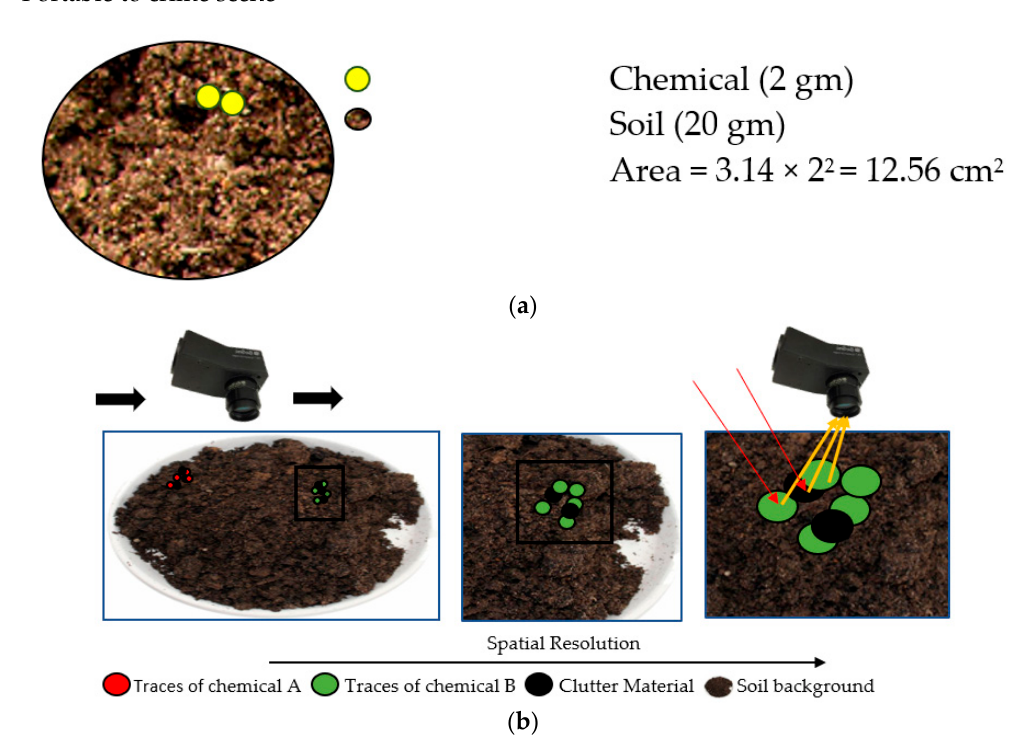
Figure 1. ( a ) Conceptual example of traces of chemicals present on the soil surface in a petri dish of 4 cm diameter; ( b ) Conceptual example of a standoff trace detection sensor illustrating key challenges associated with standoff trace explosive chemical detection.